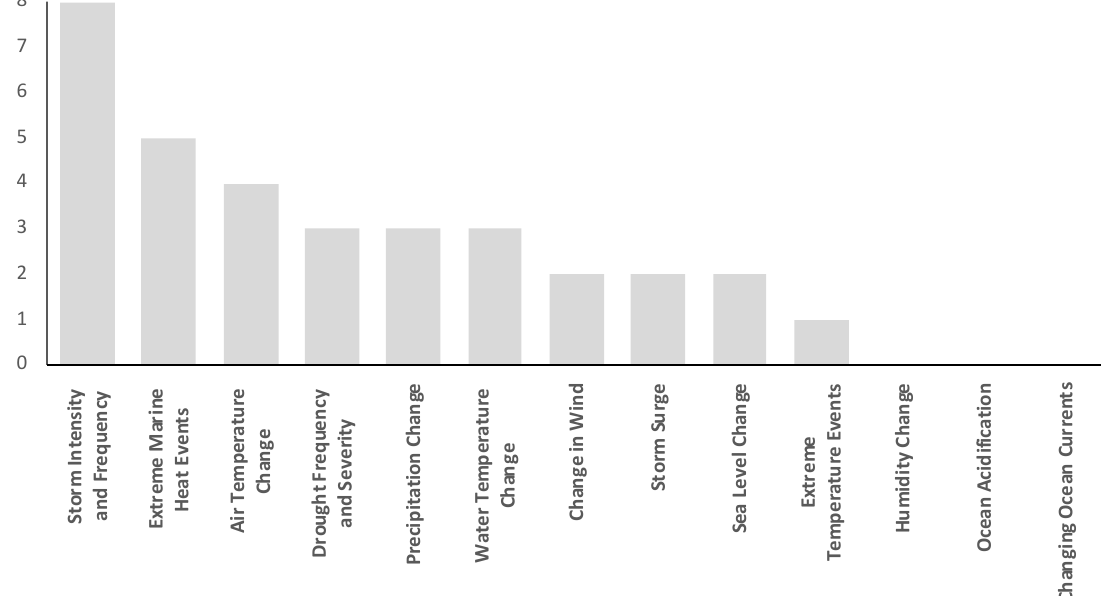
Figure 5.2 Histogram of impacts on 13 attributes of OUV from 13 climate stressors whose impacts were assessed for ca.